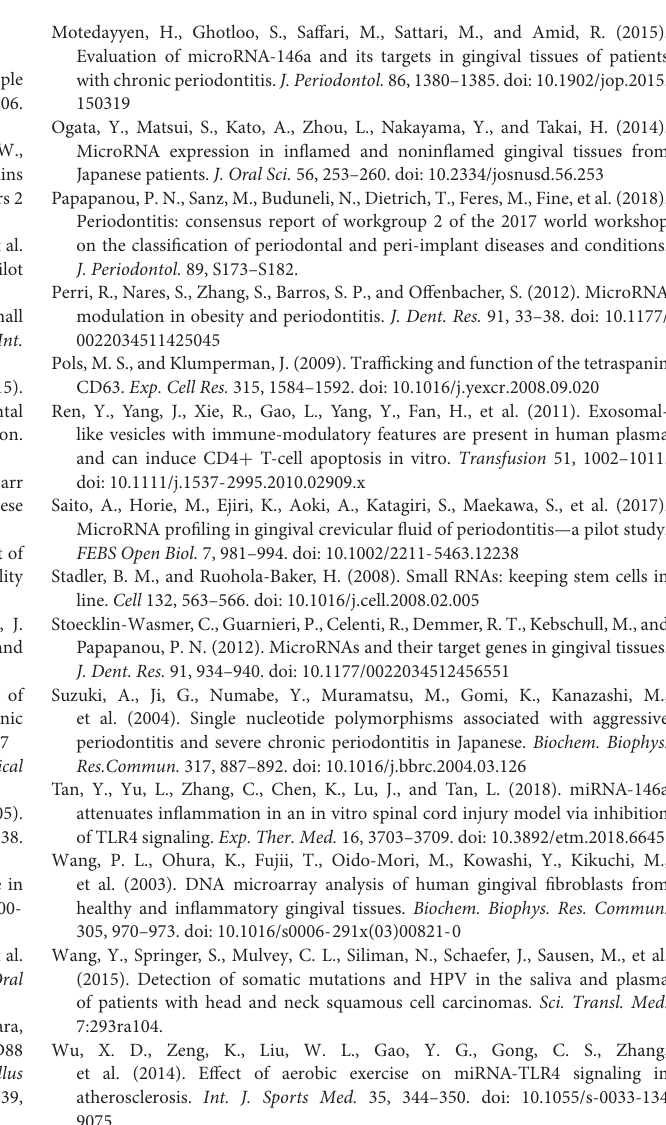
samples as compared to healthy plasma-exosomal samples; together with their area under curve table (1) . ROC curves of all 10 significantly up-regulated miRNAs in CP salivary-exosomal samples as compared to healthy salivary-exosomal samples; together with their area under curve table (2) . ROC curves of top ten significantly down-regulated miRNAs in CP salivary-exosomal samples as compared to healthy salivary-exosomal samples; together with their area under curve table (3) . ROC curves of eight miRNAs that significantly down-regulated miRNAs in both CP plasma- and salivary-exosomal samples as compared to healthy plasma- and salivary-exosomal samples, respectively; together with their area under curve table (4) . ROC curves of significantly down-regulated miRNAs in CP salivary-exosomal samples as compared to healthy salivary-exosomal samples, and parallel with previous CP studies’ findings; together with their area under curve table (5) . ROC curves of significantly up-regulated miRNAs in CP salivary-exosomal samples as compared to healthy salivary-exosomal samples, and parallel with previous CP studies’ findings; together with their area under curve table (6) . All the ROC curves with AUC = 1 have significant p -value ( p -value = 0.05), while ROC curves with AUC value < 1 does not have significant p -value ( p -value >